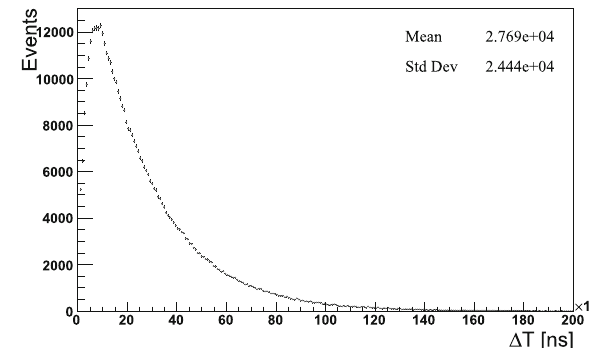
Fig. 11 Reconstructedprompteventsenergydistributionfromthesim- ulated IBD events